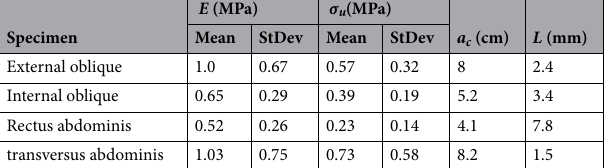
Table 2. Critical dimensions of cracks (or hernia defects) in abdominal muscles.